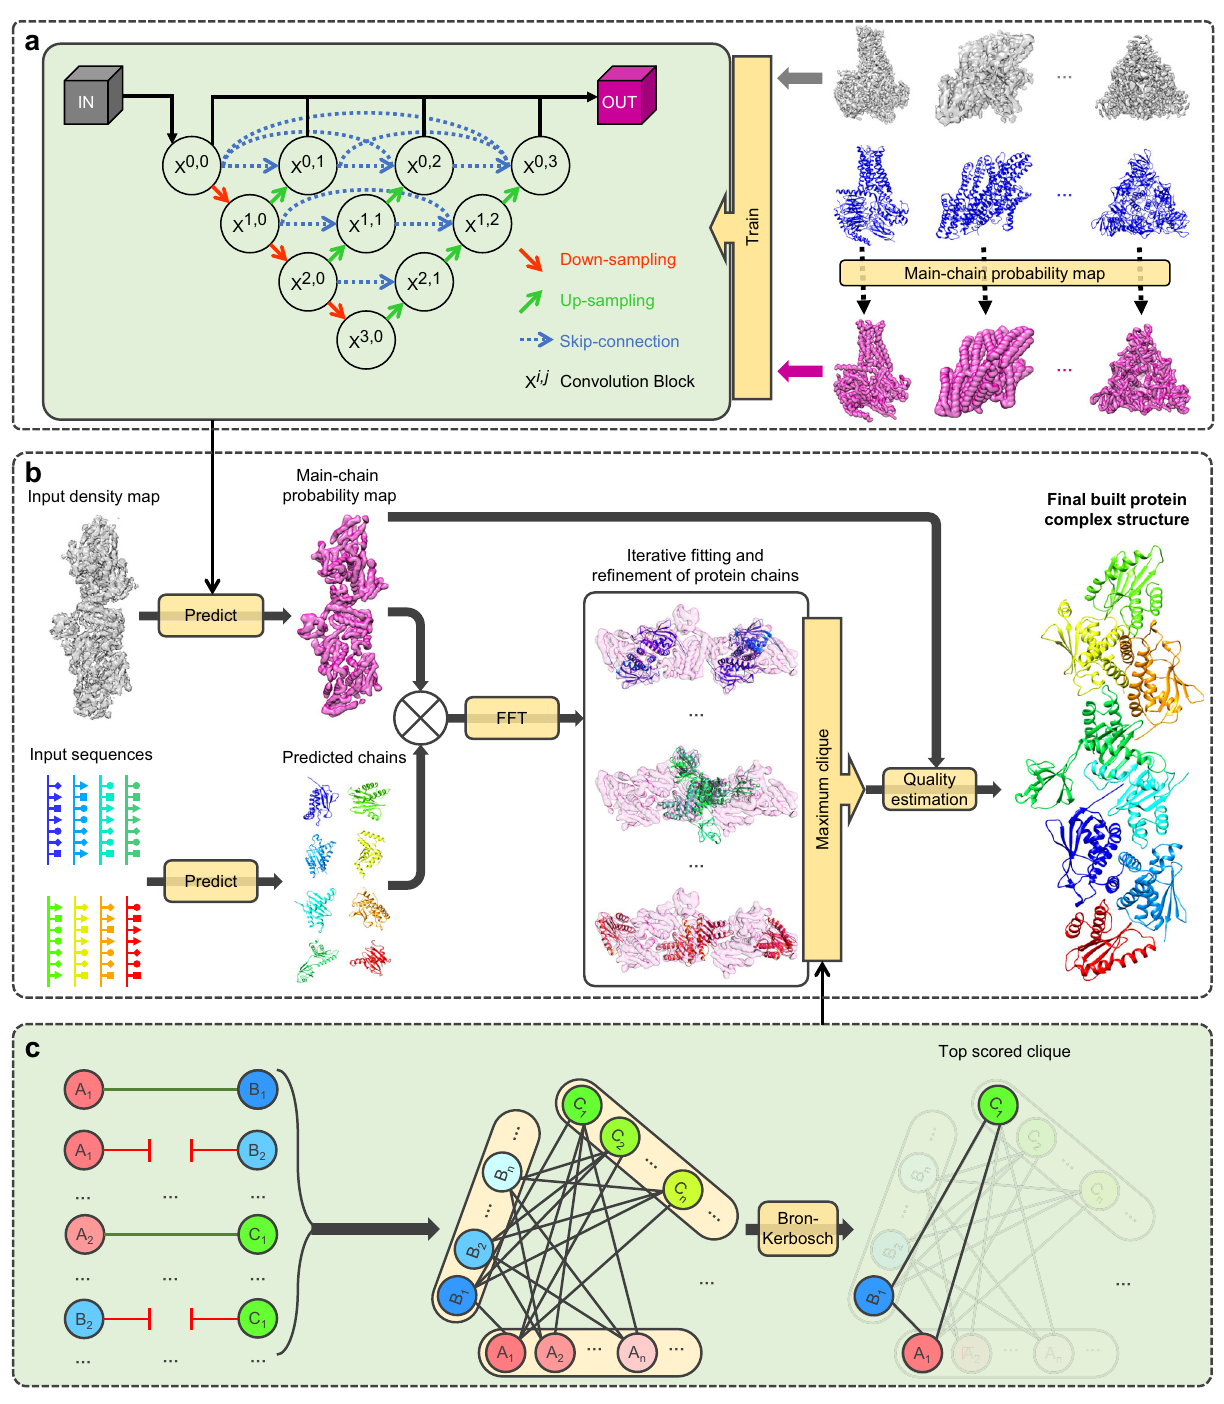
Fig. 1 Overview of the EMBuild work fl ow. a The training strategy of the deep learning module for main-chain probability prediction. The deep learning module adopts a UNet ++ 51 architecture. The training set consists of pairs of experimental EM maps and main-chain probability maps computed from associated PDB structures. b The work fl ow of EMBuild. The input of EMBuild is the EM density map and its corresponding sequences of individual protein chains. The main-chain probability map is predicted from the input density map using our trained deep learning model. The atomic models of individual chains are predicted from their sequences by a structure prediction program. A set of predicted chain models are individually fi tted to the main-chain probability map through an FFT-based fi tting and re fi nement. With all the fi tting results of individual chains, the fi nal protein complex structure is built through a Bron-Kerbosch maximum clique algorithm. c Schematic of the Bron – Kerbosch maximum clique algorithm. The clash scores between two fi tted poses from different chains are calculated. Two poses are connected (green line) if the clash score is below a certain threshold, and are disconnected (red break line) if the clash score is above the threshold. Then, a graph is generated where each vertex has the fi tting score of its associated pose. The Bron- Kerbosch search algorithm is used to fi nd the top-scored combination of chains that are adjacent to each other, i.e., the top-scored